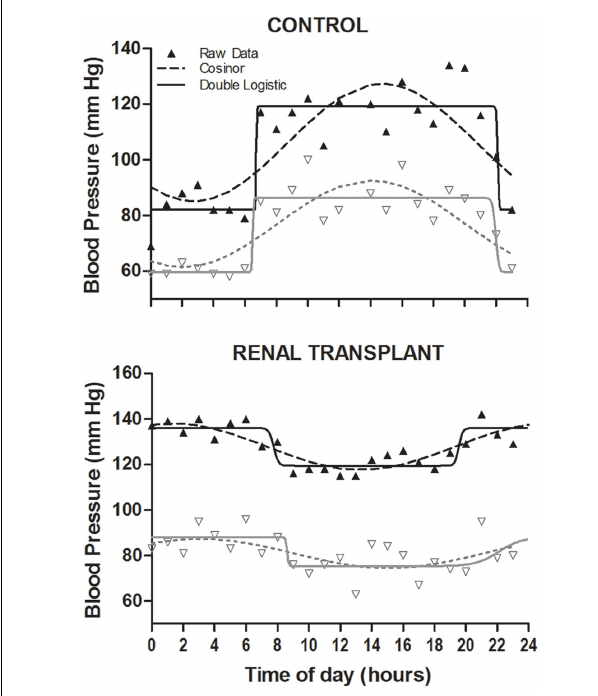
FIGURE 1 | Individual examples of the modeling procedures in both groups. The upper plot corresponds to a control individual and the lower plot to a renal transplant recipient. Double-logistic fitting is plotted with solid line and Cosinor fitting with dash–dot line. Black filled triangles are SAP hourly values and white filled triangles DAP values.